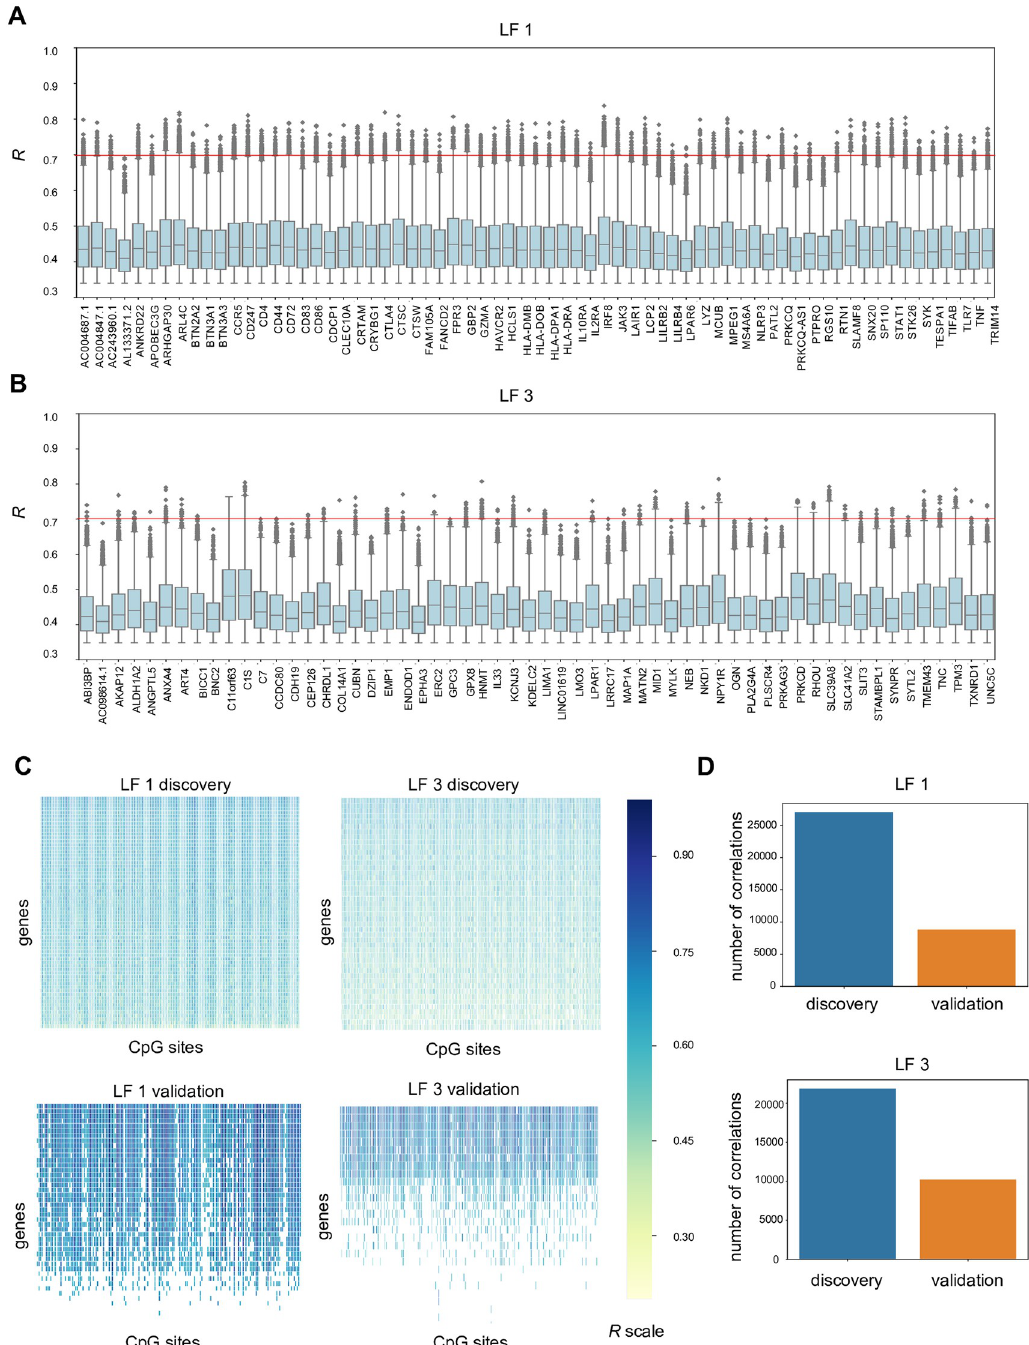
Fig 6. Distribution of correlation coefficients for the gene features within 90 th percentile of node degree for latent factor 1 and latent factor 3. A) Box plots represent the correlation coefficients of the gene features that fall into the 90 th percentile of node degree for latent factor 1. B) Similarly, boxplots for the features belonging to latent factor 3 are represented. C) The contingency matrix shows the top correlations ( R > 0.7) with the gene and CpG features for latent factor 1 and 3, along with the contingency matrix for the validation cohort. D) The bar-plots represent the number of correlating pairs part of the discovery and validation cohorts.